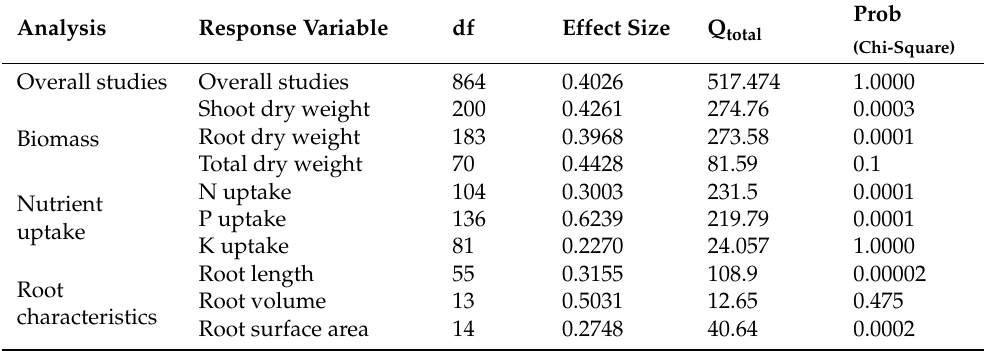
Table 1. AMF inoculation effect on plant growth and nutrient uptake under drought stress.